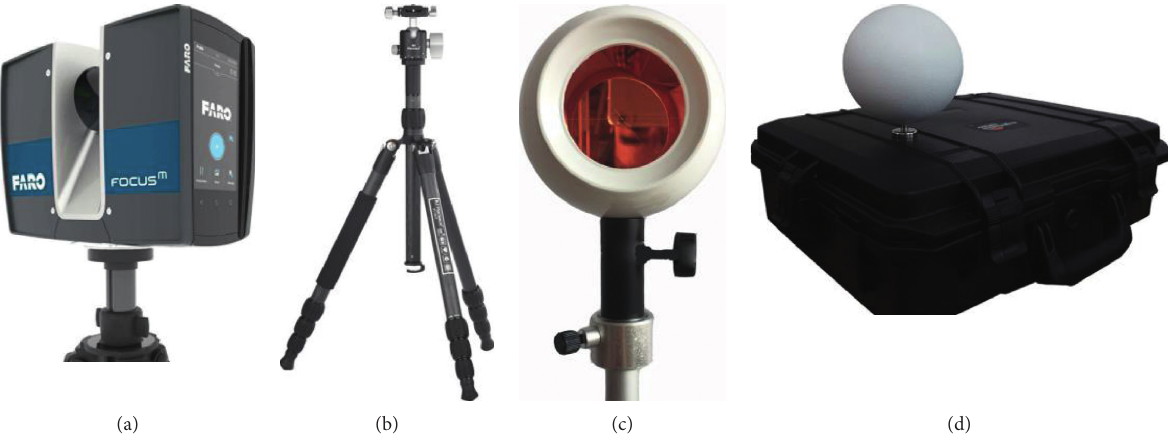
Figure 3: 3D laser scanning system